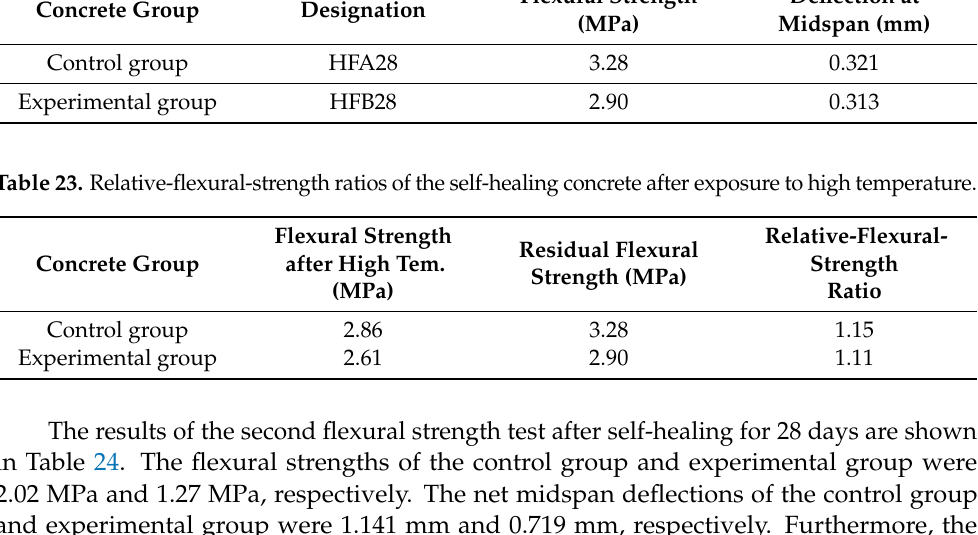
Table 22. Test results of the flexural strength of the self-healing concrete after exposure to high temperature.